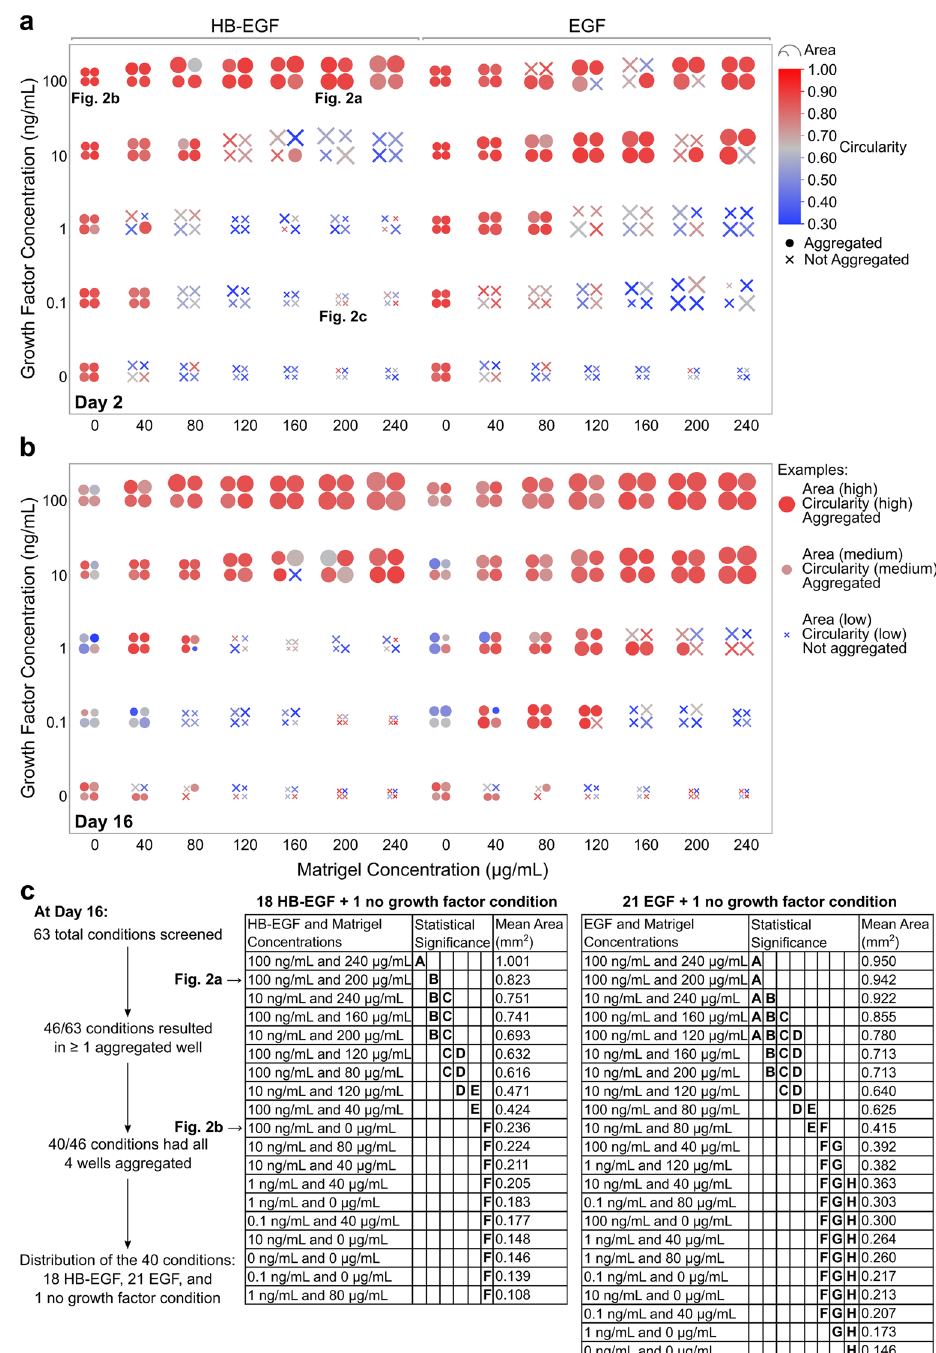
Figure 3. Screening the effects of Matrigel and growth factor concentration on organoid formation. Summary of organoid formation under 63 different Matrigel and growth factor combinations at ( a ) day 2 and ( b ) day 16. Projected area, circularity, and whether the structure is aggregated or not aggregated are represented by the marker size, color, and shape respectively. Each marker represents a different replicate in a quadruplicate study. Conditions are divided by growth factor type (HB-EGF: left, EGF: right), and the no growth factor conditions are duplicated on both sides for ease of visualization. ( c ) Statistical analyses of the most consistent conditions with 4 out of 4 wells aggregated at day 16 are shown. Conditions not connected by the same letter have significantly different areas (ANOVA and post-hoc Tukey test: P < 0.05). Conditions depicted in Fig. 2 are